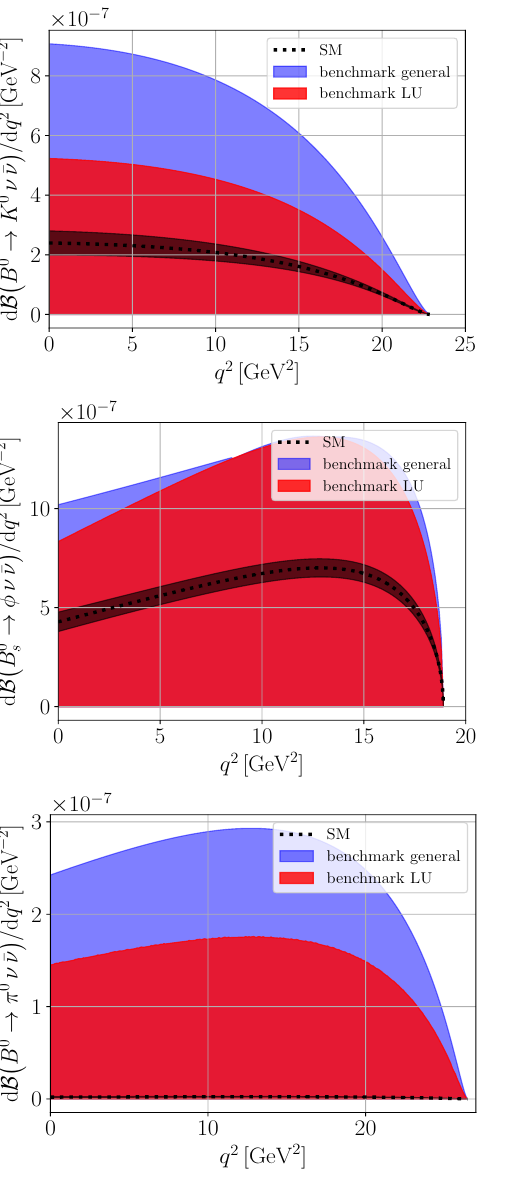
→ φ ν ¯ ν , B 0 → X s ν ¯ ν , s